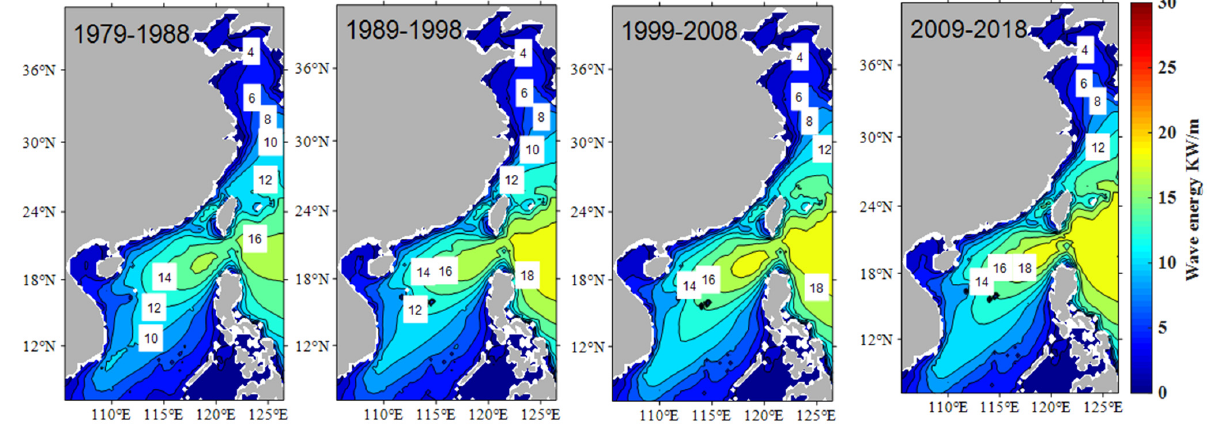
Figure 5. Decade distribution of P w .